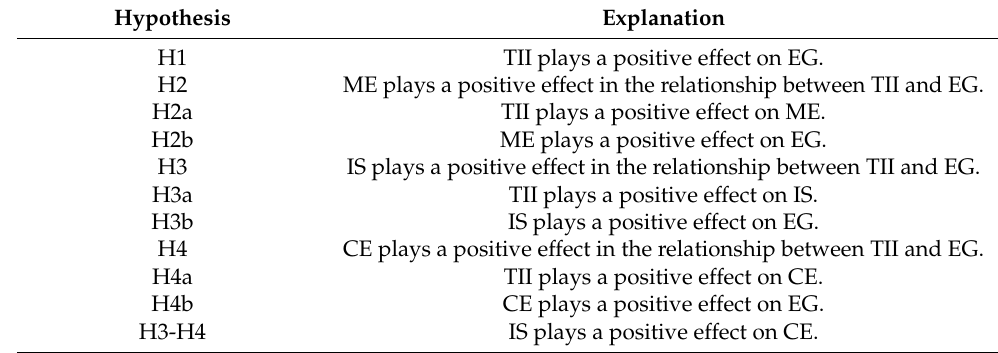
Table 10. Hypotheses in the mediation